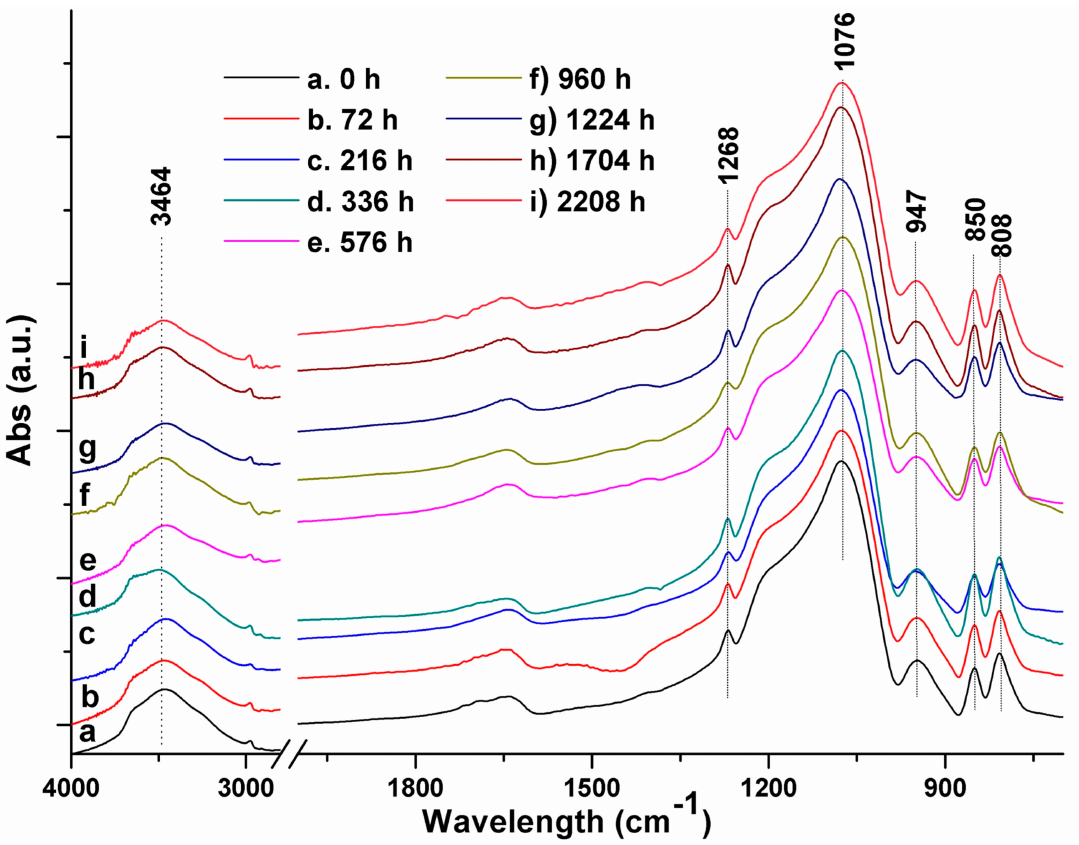
Figure 2. Fourier-Transform Infrared Spectroscopy (FTIR) analysis of the SP&T xerogel: ( a ) after the completion of the chemical reactions and ( b – i ) after the exposure to UV